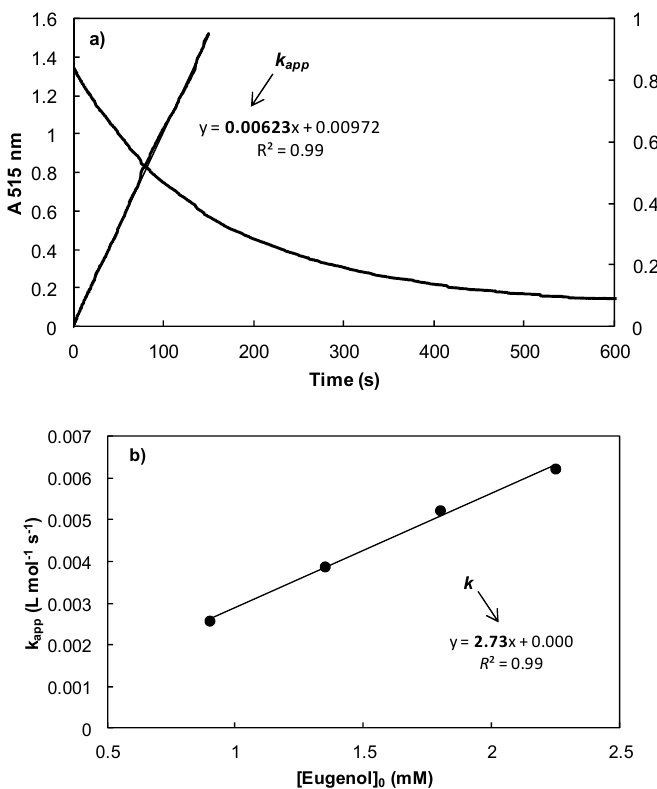
Figure 3. ( a ) Change in absorbance at 515 nm of a solution of DPPH • (1.25 × 10 − 4 M) in the presence of an excess of eugenol 61 (2.25 × 10 − 3 M) in toluene, linearization of the logarithm of the absorbance using the final pseudo-first order kinetics (FOK) (Equation (9)) as a function time; and ( b ) regression constants of apparent kinetic rates as a function of initial concentrations of eugenol 61 . To confirm that pseudo-first order kinetic (FOK) and second order kinetic (SOK) give the same results for the same phenolic antioxidants, vanillic acid 20 and eugenol 61 were studied using both conditions leading to similar rate constants k . Results are gathered in Table 3.